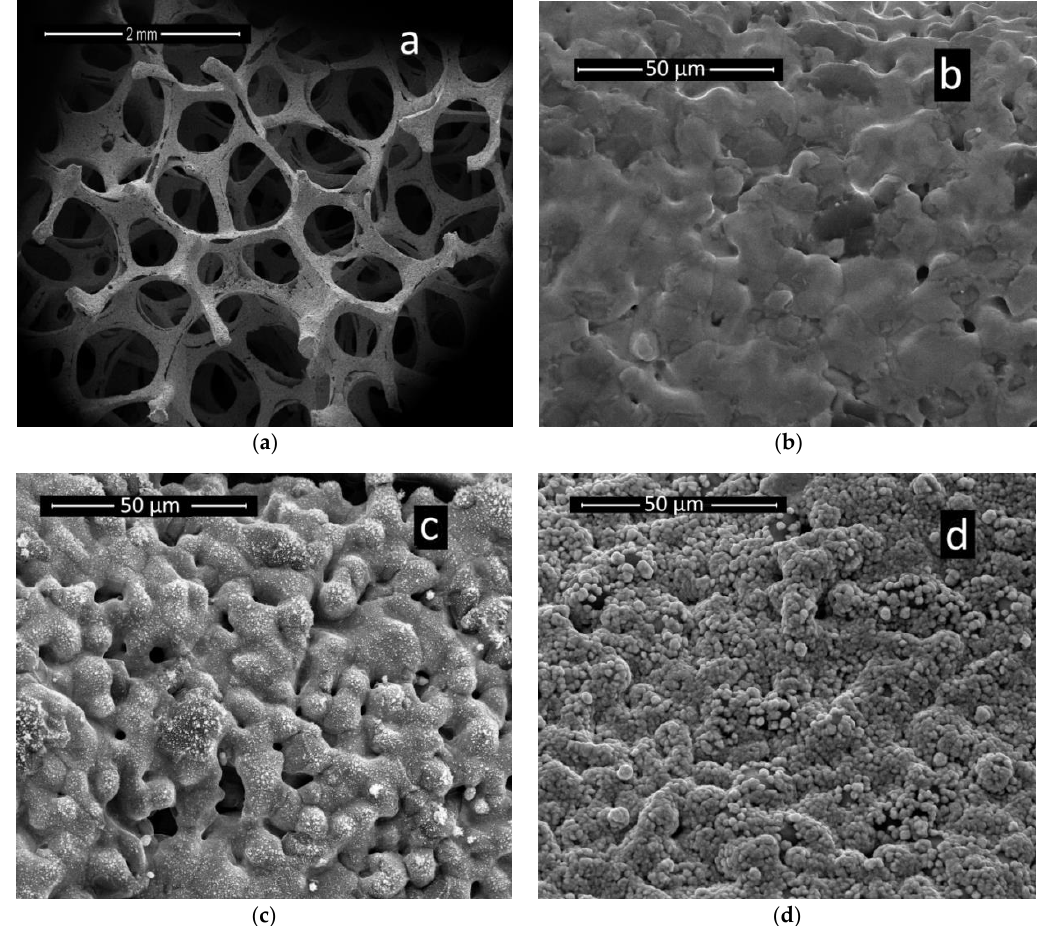
Figure 9. ( a ) SEM image of Ni-foam morphology. Surface detail of Ni foam ( b ) without catalyst, ( c ) with Pd, and ( d ) with Ni-Co alloy.